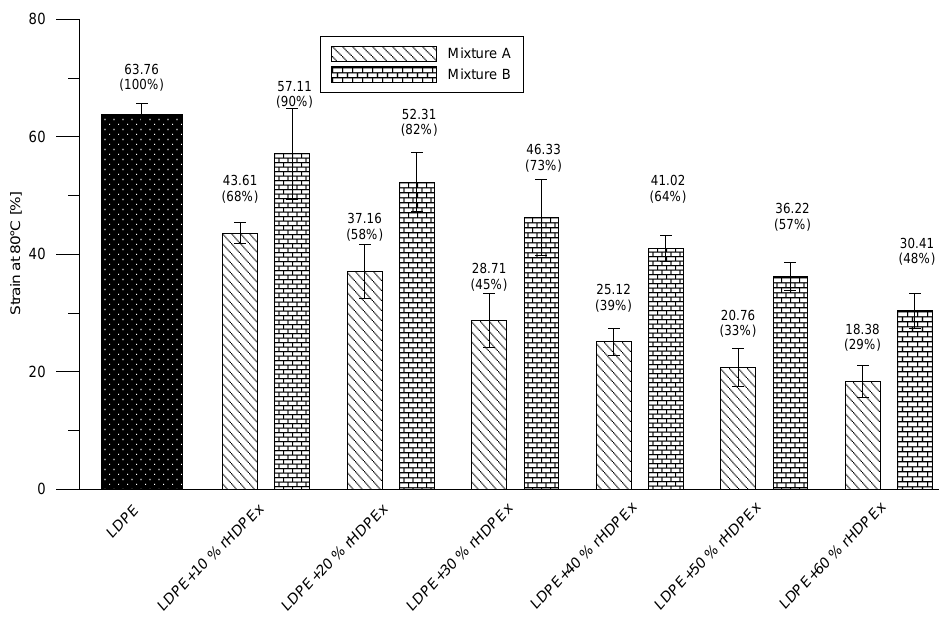
Figure 9. Strain at elevated temperature—Mixtures A and